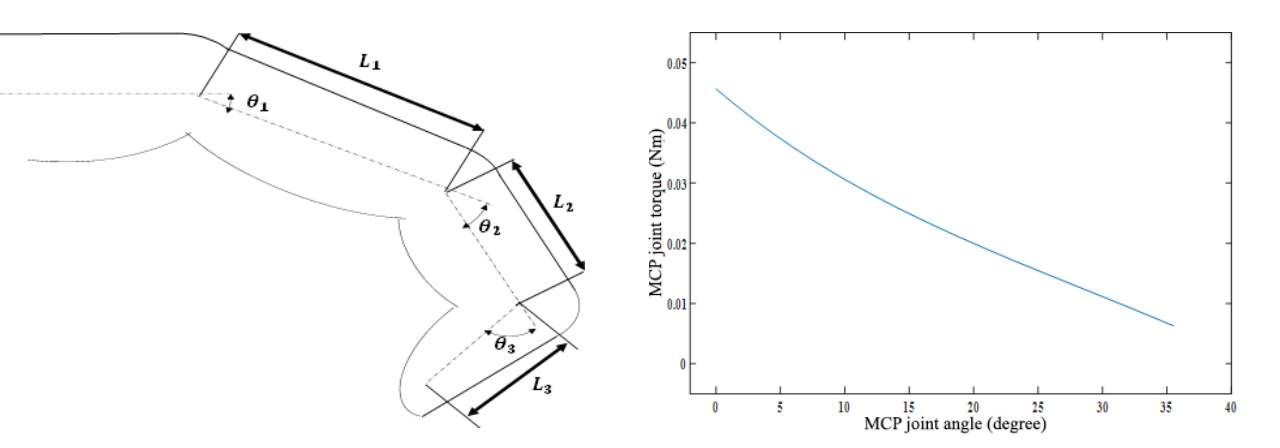
Figure 2. Active MCP joint torque of index finger for extension